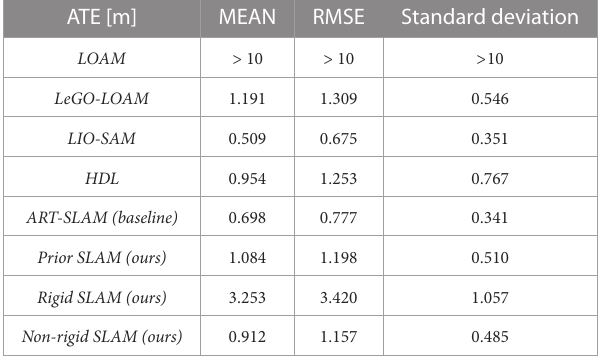
TABLE1 ATEonSequence07oftheKITTIodometrydatasetGeiger et al. (2012). ATE